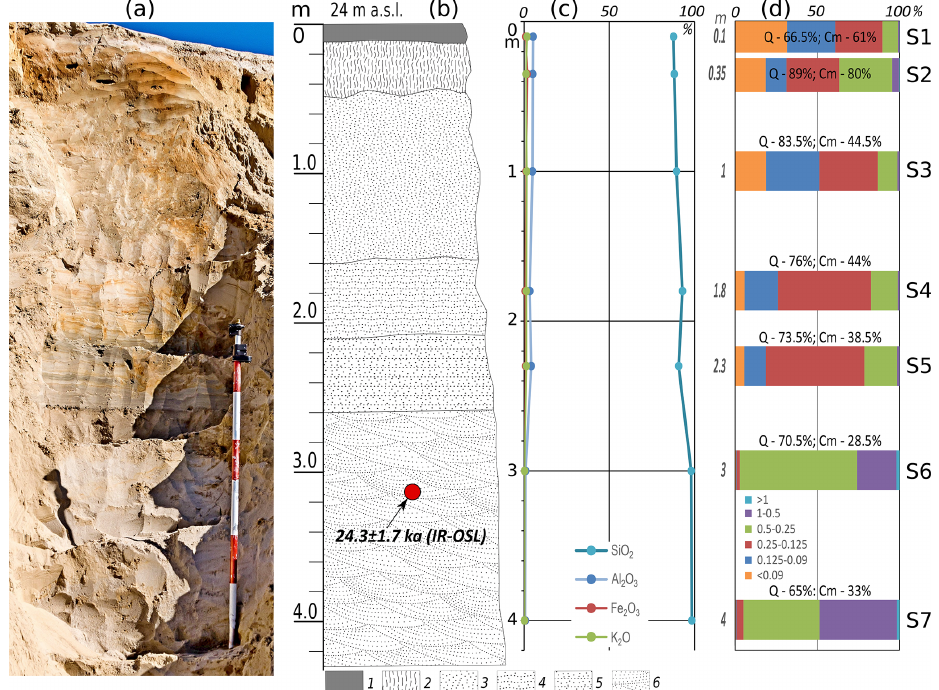
Figure 4. Summary results of research for K-1 section: (a) photograph (by Sizov in 2016); (b) geological structure and the dating results (see Table 3); (c) bulk chemical data; (d) grain size distribution (fractions,mm). Symbols: (1) podzol horizon of modern soil; (2) illuvial-iron (spodic) horizon of modern soil; (3) sands without stratification; (4) undulating sand with secondary ferruginisation; (5) horizontally layered sand with stratification of loam; (6) medium- and coarse-grained oblique sand; (7) colluvium; (8) river level; Q : coefficient of roundness of the sand quartz grains; Cm: degree of dullness; S: sample